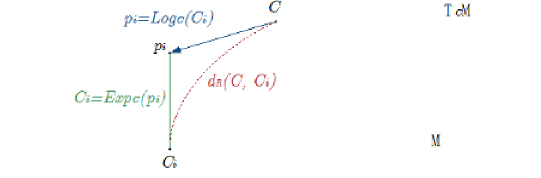
Fig. 2 . Riemannian manifold and the tangent